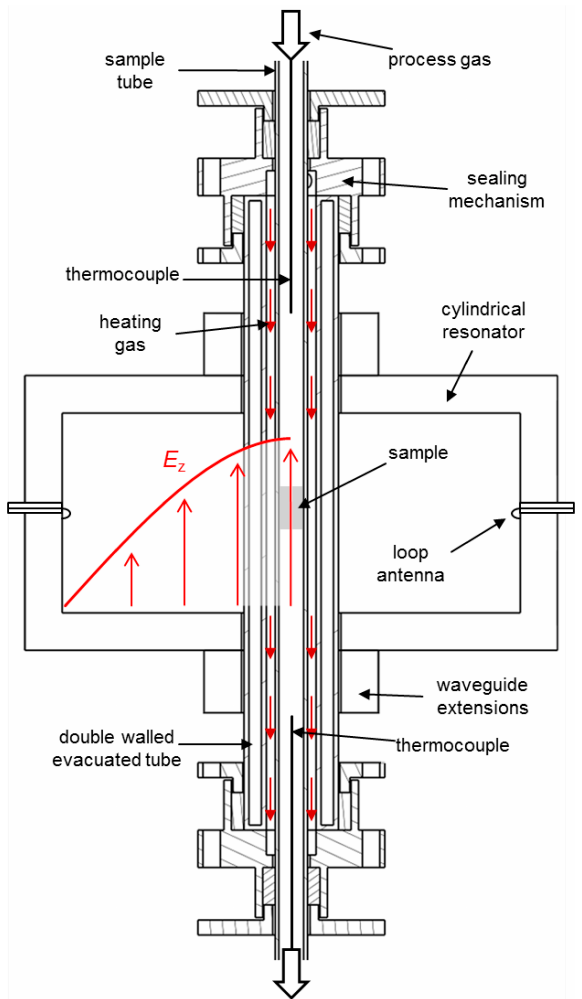
Figure 1. Schematic setup of the developed test bench including the sample tube, the double-walled and evacuated tube, the sealing mechanism, the resonator with waveguide extensions, loop antennas and two thermocouples. The gas heater, the Fourier transform infrared (FTIR) gas analyzer and the network analyzer (all external components) are not